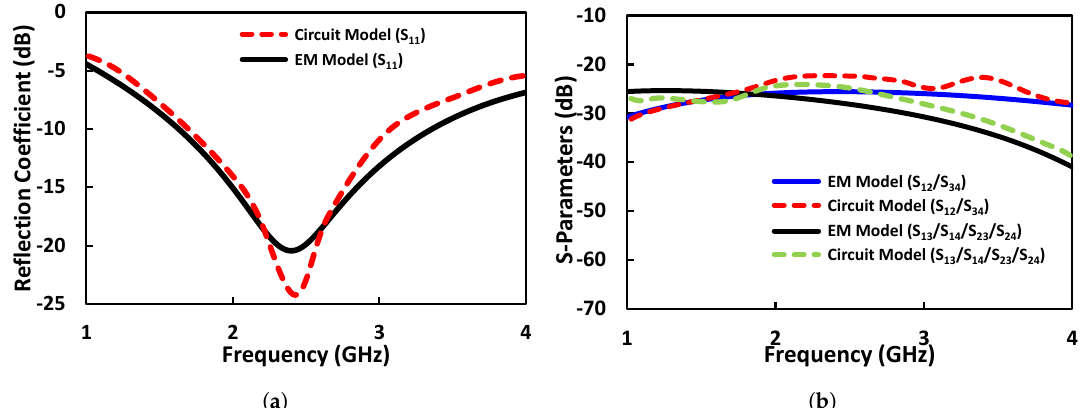
Figure 4. S-parameters comparison of the electromagnetic (EM) model and equivalent circuit model ( a ) Reflection coefficient, and ( b ) Transmission